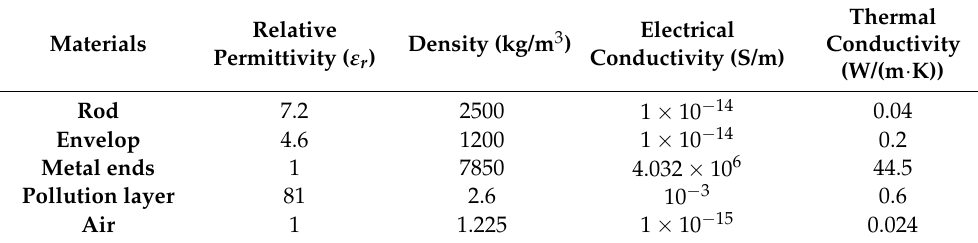
Table 2. Thermoelectric properties of the